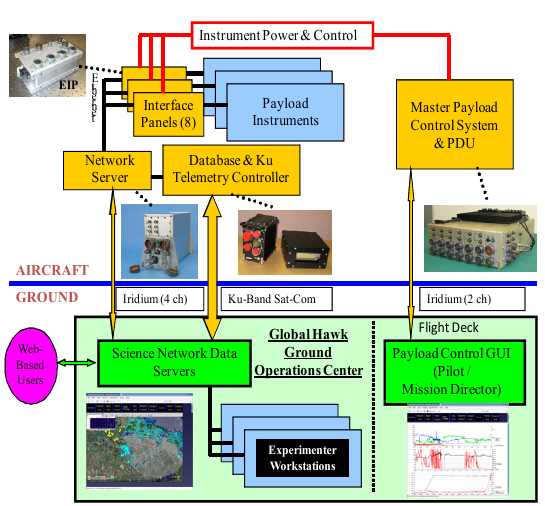
Figure 8. NASA Global Hawk UAS Real-Time Payload Communications & Control Systems Block